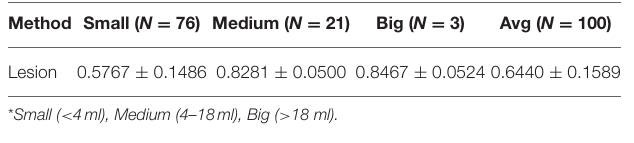
TABLE 3 | Proposed method lesion dice results.